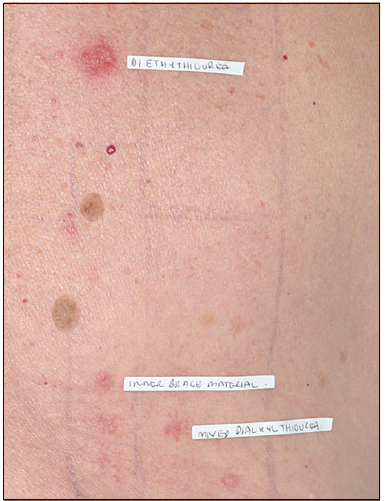
Figure 3: Positive patch test reaction to mixed dialkylthiourea, diethylthiourea, and the supports’